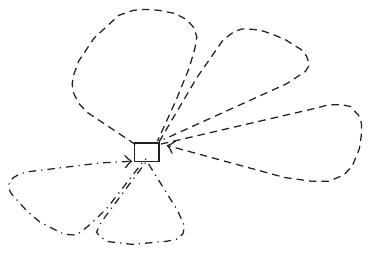
Figure 1: The milk-run vehicle routes of two vehicles.